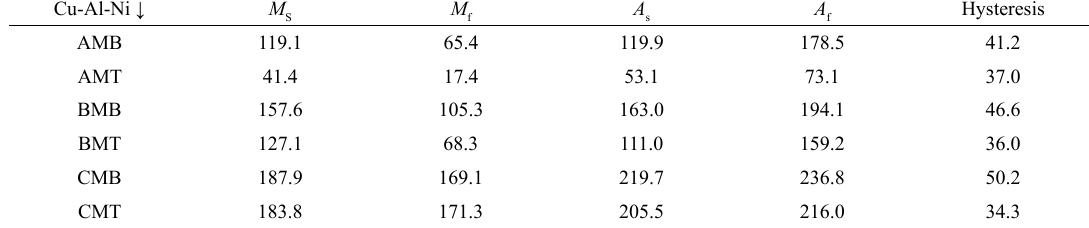
Table 4. Transformation temperatures and thermal hysteresis (ºC) of the modified aluminum bronzes (Cu-Al-Ni SMA). Cu-Al-Ni ↓